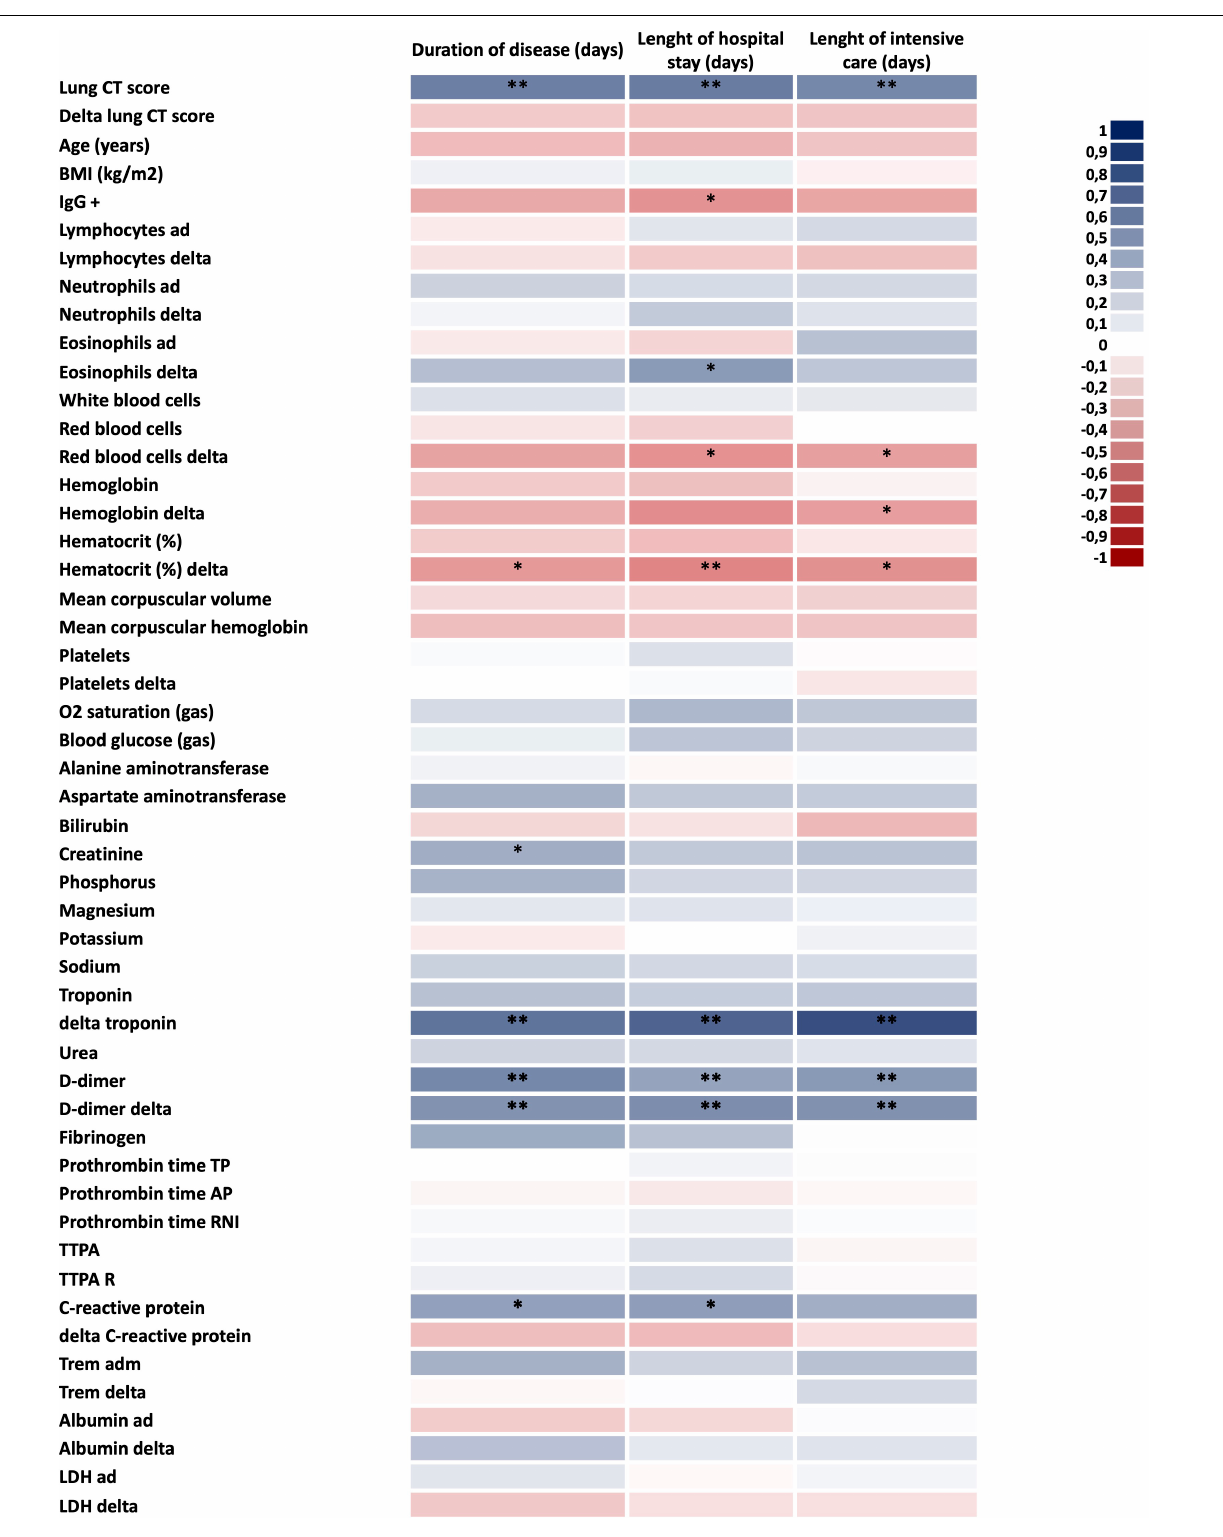
Frontiers in Cardiovascular Medicine |